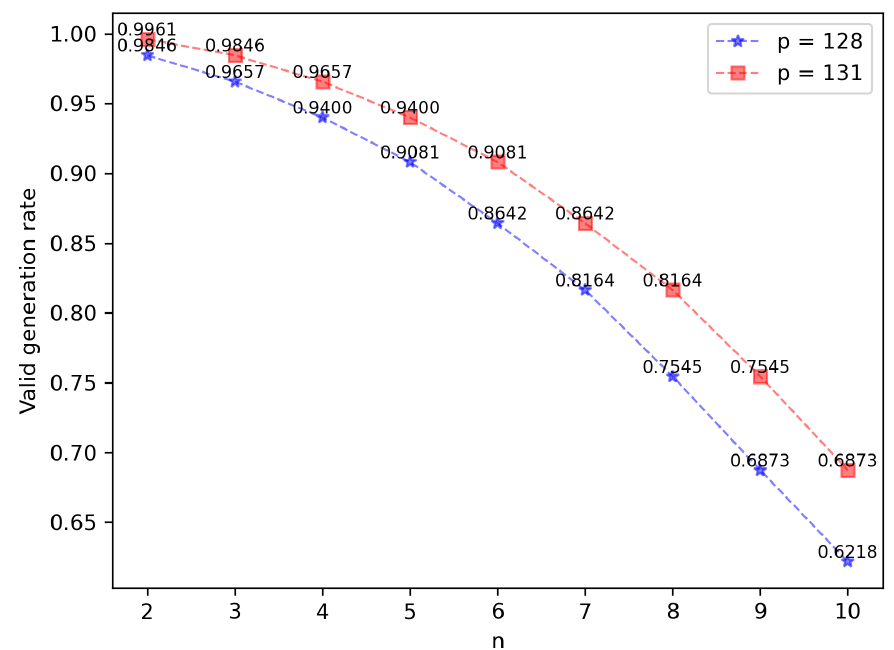
Figure 9. The valid generation rate with the increase of n